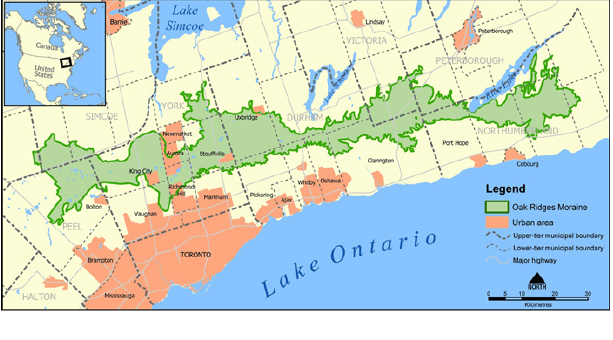
Fig. 1 . Map of the Oak Ridges